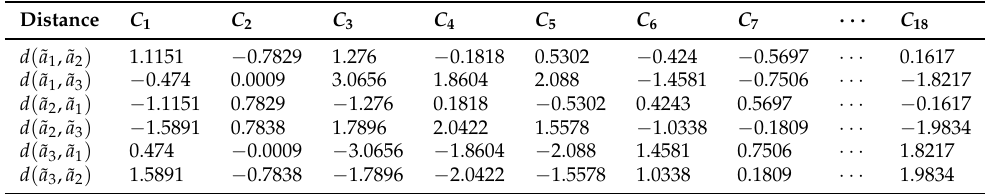
Figure 2. Rating results for the public safety education venues. Table 7. The distance between the different venues.